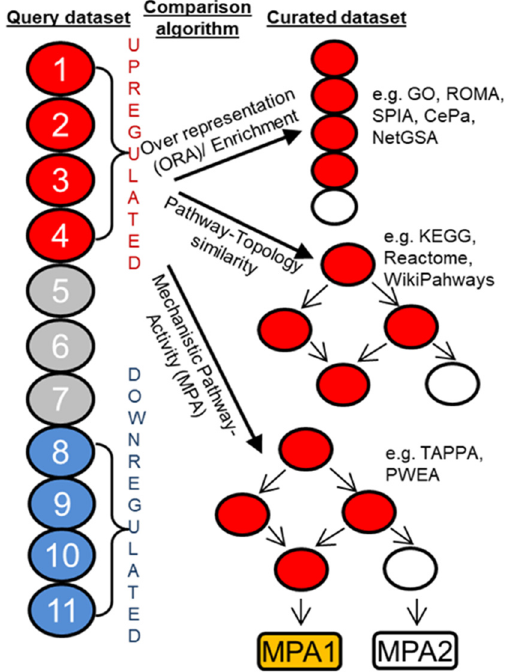
Figure 5. Pathway analysis methods. Comparison of test dataset with curated databases can be performed in many ways- based on over representation, pathway topology-based, mechanistic-pathway activity.